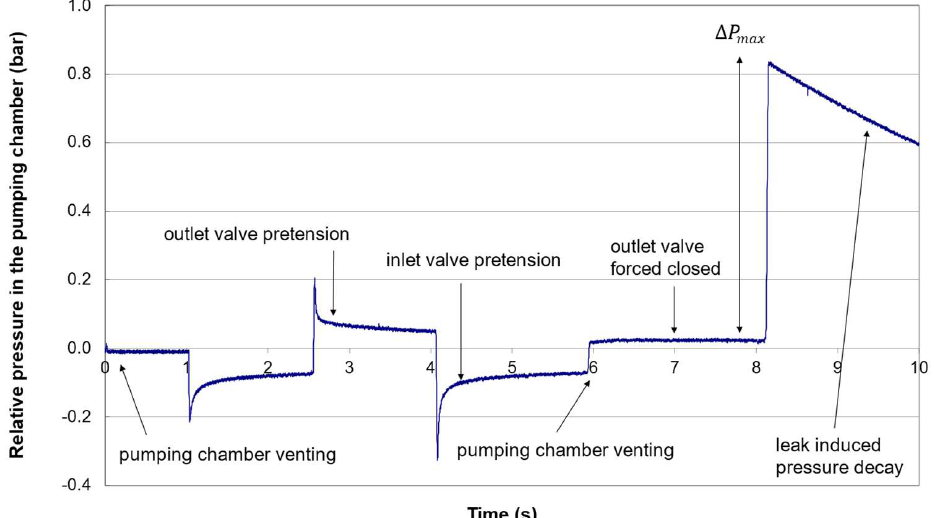
Figure 10. Typical pressure profile of a functional micropump during the dry test sequence. Positive (and negative) peaks of pressure are induced by the push (and pull) movement of the actuator. The arrows indicate the actions on the outlet valve (venting or pressurization to force the valve closed) and the measurement points for the estimated parameters. The compression test followed by the evaluation of the leaks is performed together with the application of a large pressure at the outlet valve vent to keep it closed. Before this final test, a venting of the pumping chamber at 𝑡 = 6 s is performed to improve measurement accuracy.